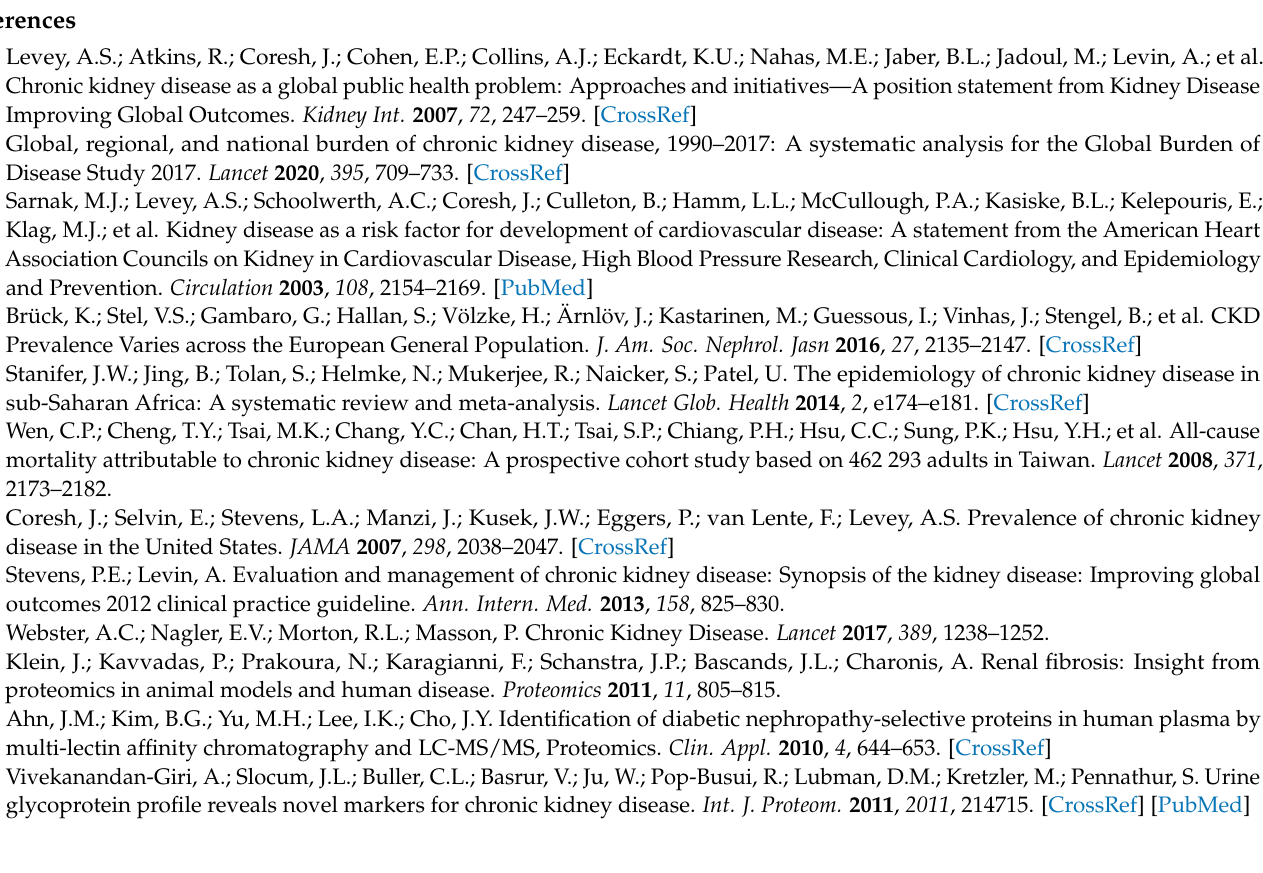
plasma. Correlation coefficients (r) of calibration curves are listed in the table, Table S2: Characteristics of 57 participants in the study, Table S3: Results of correlation analysis of natural abundances and normalized abundances of 26 IgG glycopeptides to the eGFR values; Figure S1: Statistical analysis of plasma concentrations of IL-6 (a) and TNF- α (b) between groups with eGFR values lower and higher than 60 mL/min/1.73 m 2